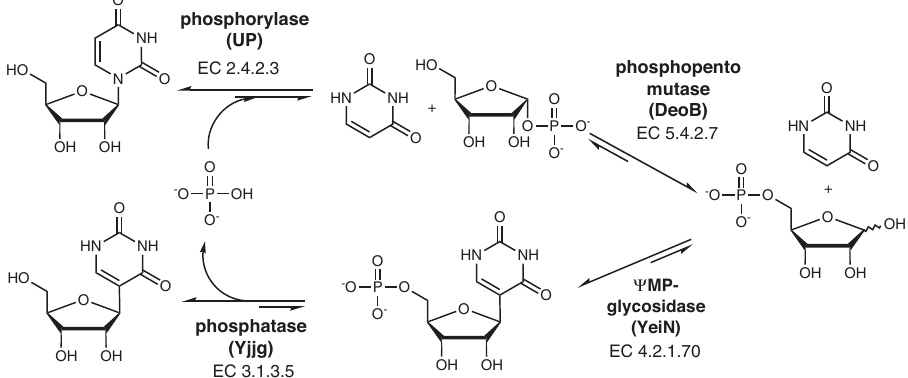
Fig.2|Proposedenzymatic N 1- C 5rearrangementfromUto Ψ . Therearrangementproceedsinfourenzymaticstepsinaone-pottransformation.Theenzymesusedare identi fi ed by name and EC number. Phosphate is recycled in the